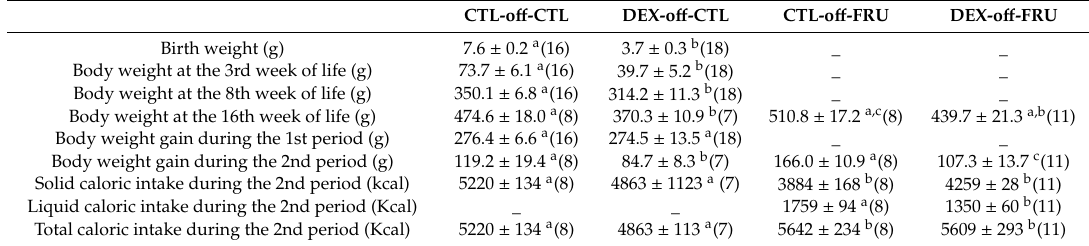
Table 2. Body weight and caloric intake throughout the experimental period. Means with di ff erent superscript minuscule letters are significantly di ff